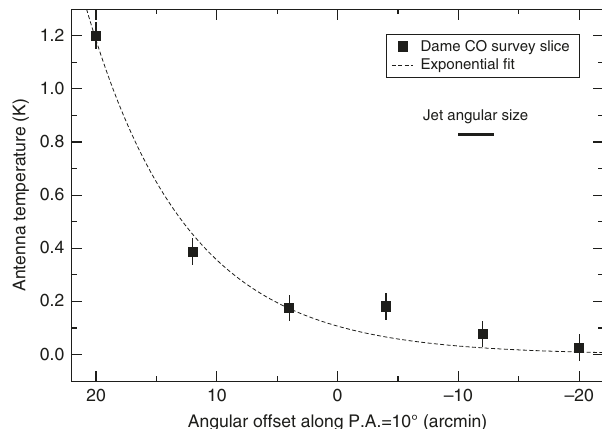
–20–1001020 Angular offset along P.A.=10° Fig. 4 Slice of CO emission centred on GRS 1758-258. The black squares taken from the Dame survey illustrate how the CO antenna temperature changes along the position angle of the microquasar jets. Error bars are de fi ned as one standard deviation of the emission-free background. The left side corresponds to the direction of molecular cloud impingement, whereas the right side denotes the region far away from it. The dashed line displays the exponential fi t used in the main text to estimate the density variations on scales comparable to the jet angular size (3 arcmin long thick horizontal bar)